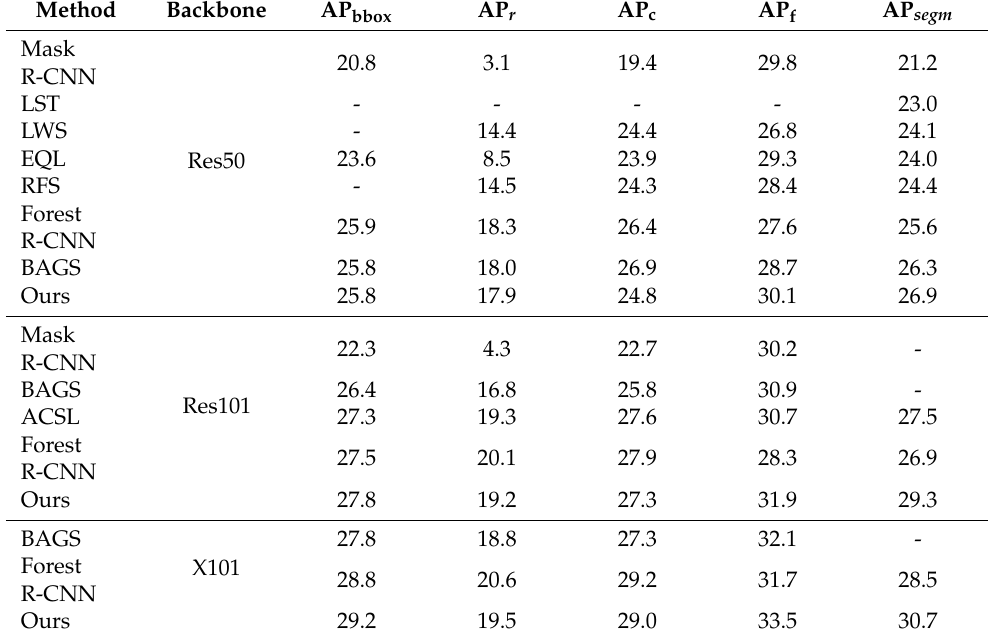
Table 4. Comparison with state-of-the-art methods on the LVIS v0.5 validation